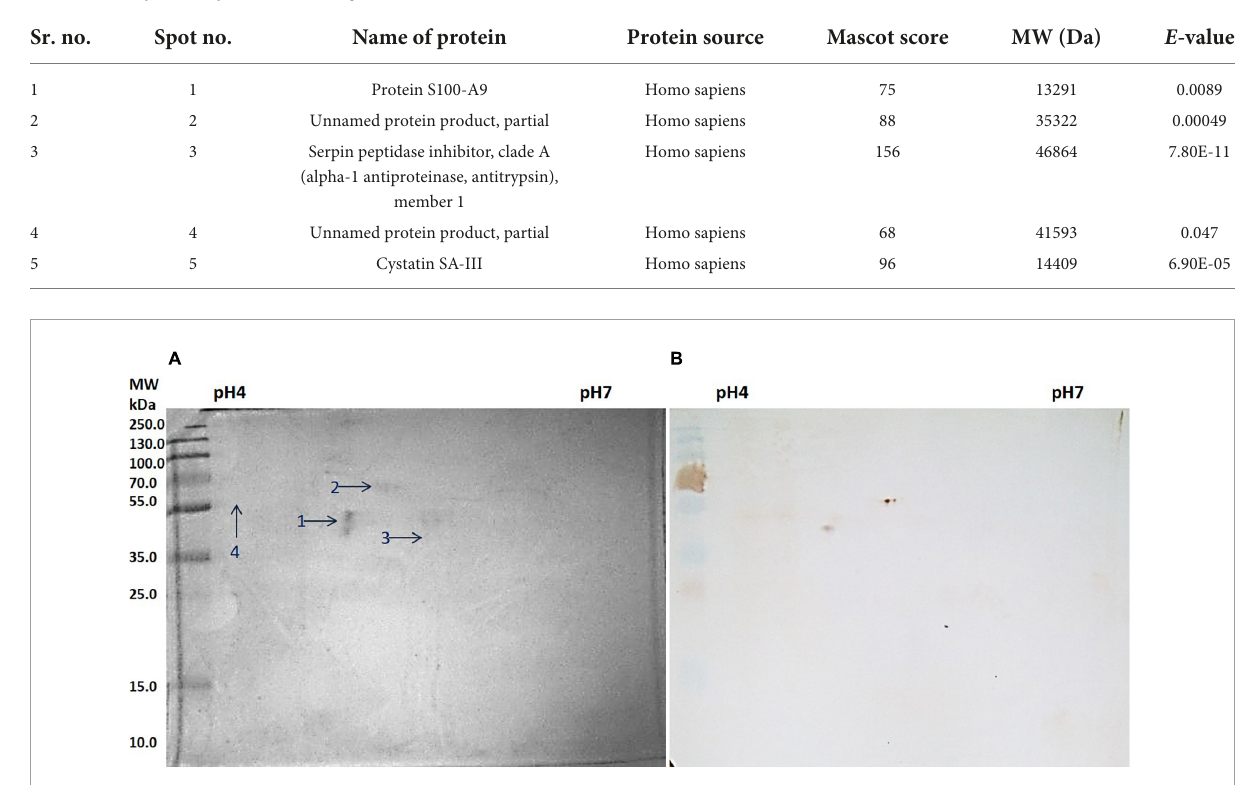
FIGURE3 (A) Two-dimensional (2D) gel electrophoresis profile of slit skin scrapings (SSS). (B) Western blot against anti Mycobacterium leprae IgG.